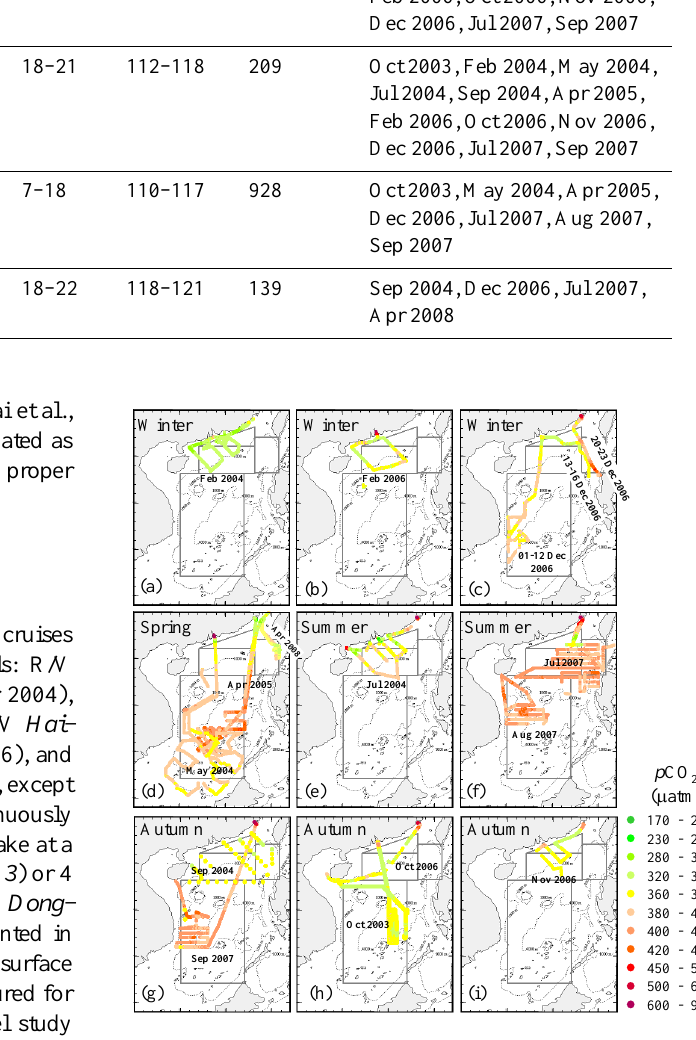
Fig. 2. Sampling sites and spatial distributions of sea surface p CO 2 during mapping surveys conducted between October 2003 and April 2008. The legends for (a) to (i) are the